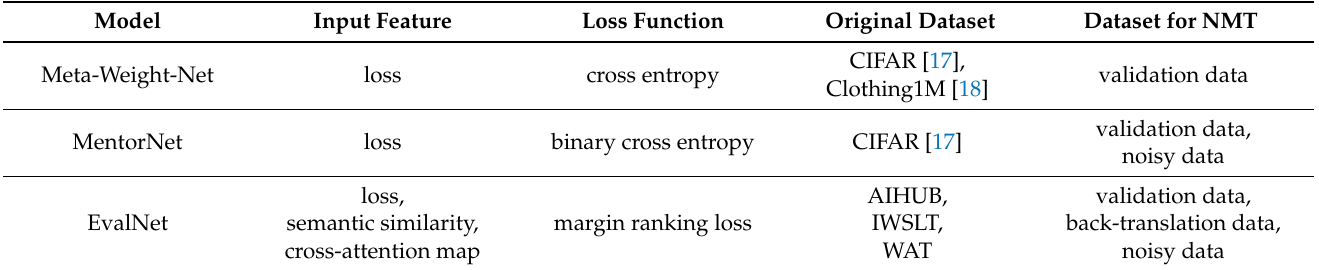
Table 6. Model comparisons with previous weighting models.